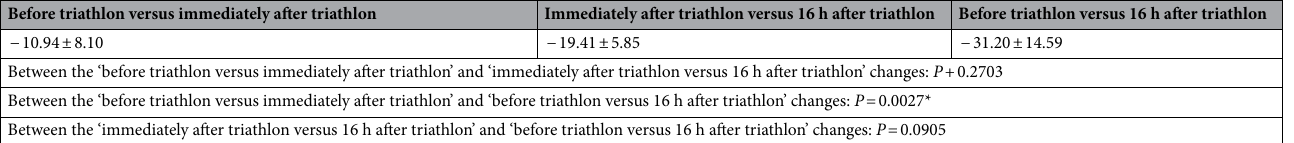
Before triathlon